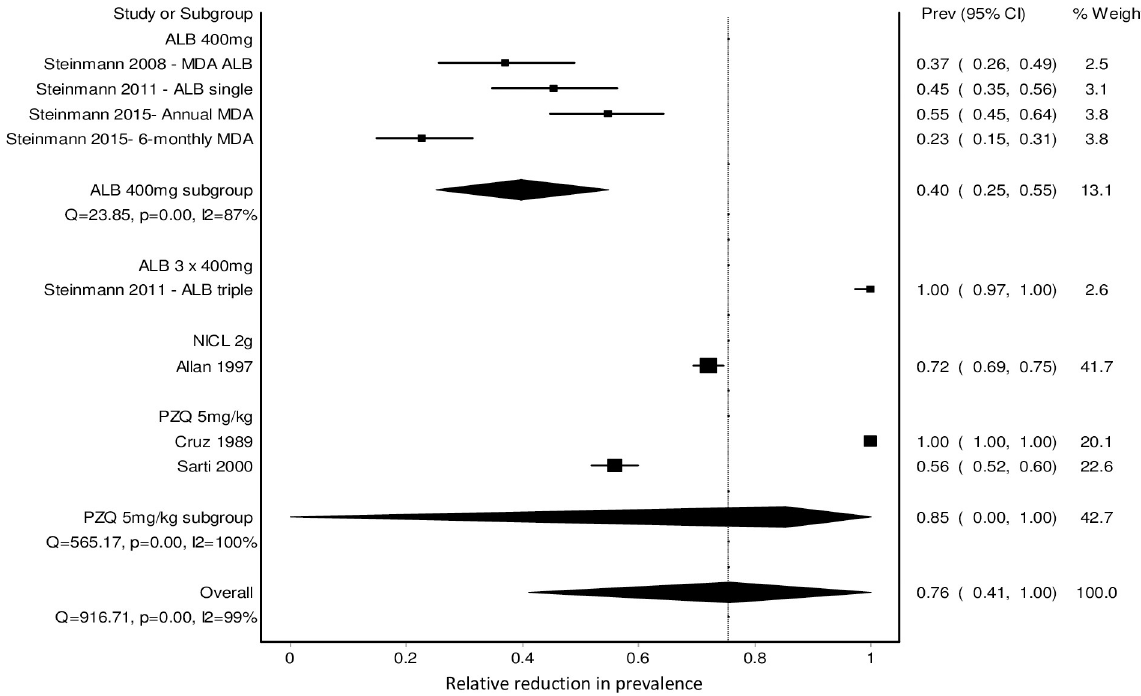
Fig 4. Forest plot showing the effect of preventive chemotherapy with different drugs and doses on the relative reduction in prevalence for T . solium